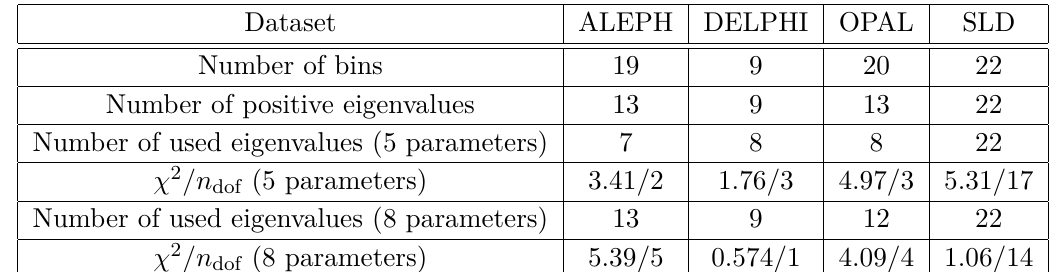
for both central fits for all four datasets. dof